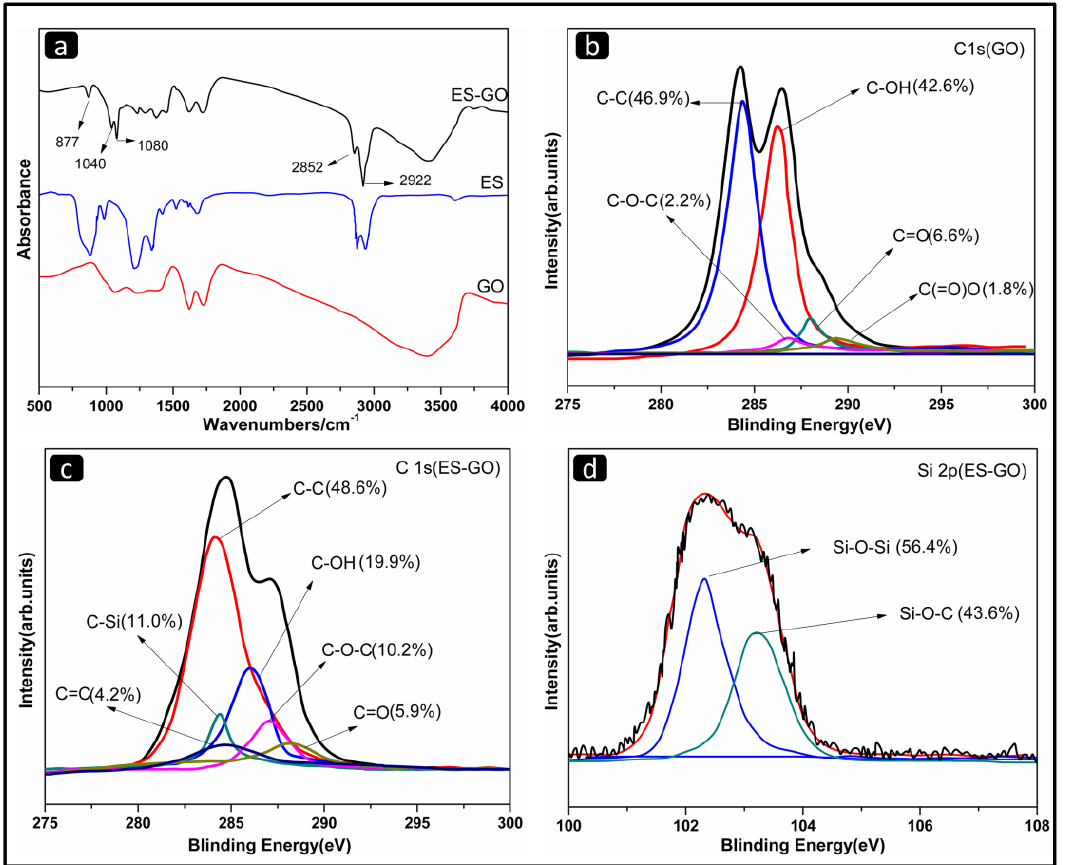
Figure 2. ( a ) Fourier transform infrared (FTIR) spectra of GO, ES and ES-GO;( b ) C1s X-ray photoelectron spectroscopy (XPS) spectra of GO; ( c ) C1s XPS spectra of ES-GO; ( d ) Si2p XPS spectra of ES-GO.